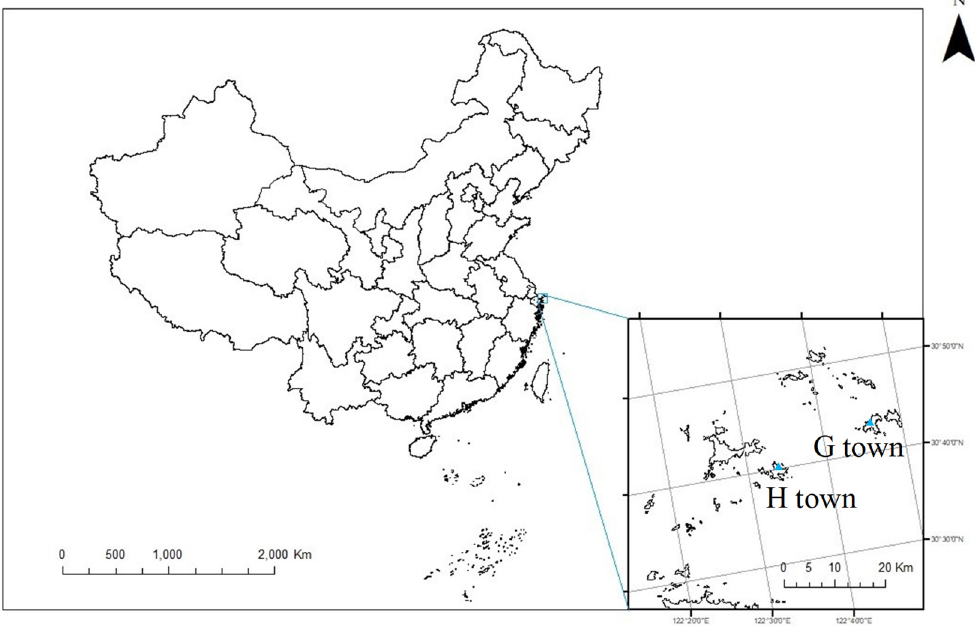
Figure 1. The study sites of Huang Long Town (H town) and Gou Qi Town (G town) in Shengsi